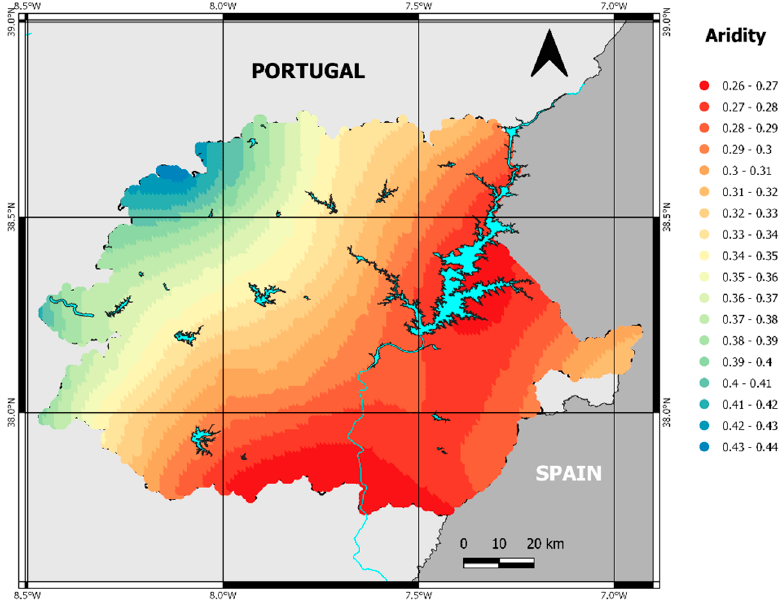
Figure 2. Aridity Index map of the study area, according to UNEP classification [55]: hyper-arid ( < 0.05); arid (0.05–0.2); semi-arid (0.2–0.5); dry sub-humid (0.5–0.65); humid ( ≥ 0.65).